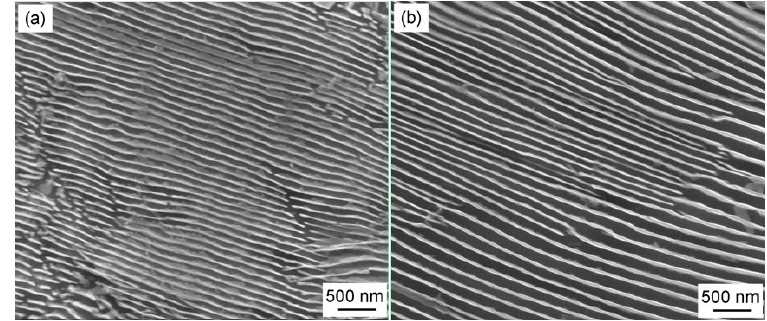
Figure 5. SEM (Scanning Electron Microscope) micrographs of the tested steels at a cooling rate of 0.1 °C/s; ( a ) Alloy 1, and ( b ) Alloy 2.